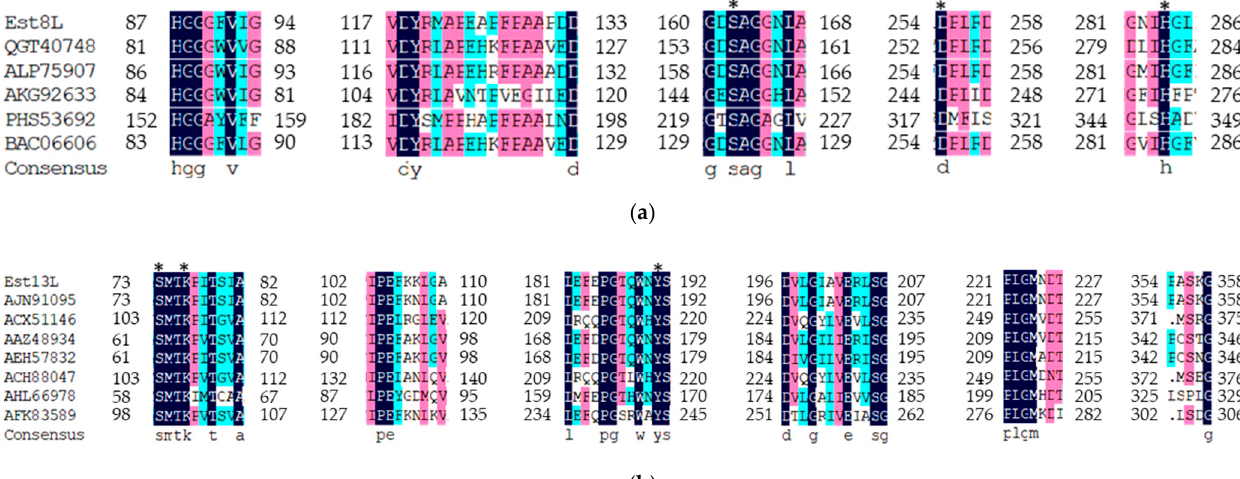
Figure 1. A phylogenetic tree of Est8L and Est13L using the maximum likelihood method. The number at the node shows bootstrap percentages of 1000 replicates. The accession numbers were from GenBank.